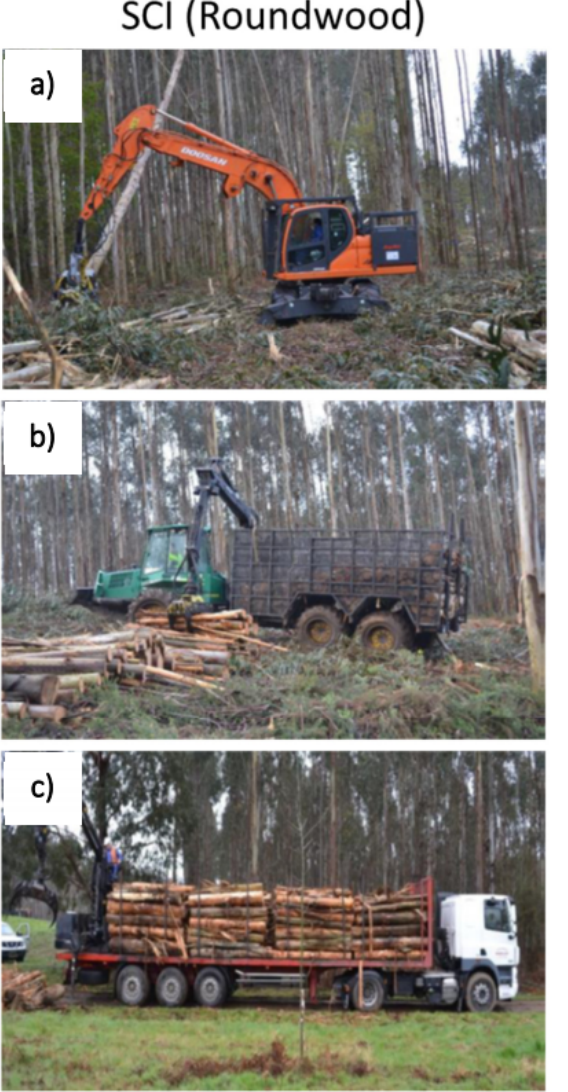
Figure 3. Equipment used in SCI and SCII: ( a ) Tree felling, debarking, debranching, ( b ) extraction of logs, ( c ) transport of logs, ( d ) bundling, ( e ) extraction of bundles, ( f ) transport of bundles.